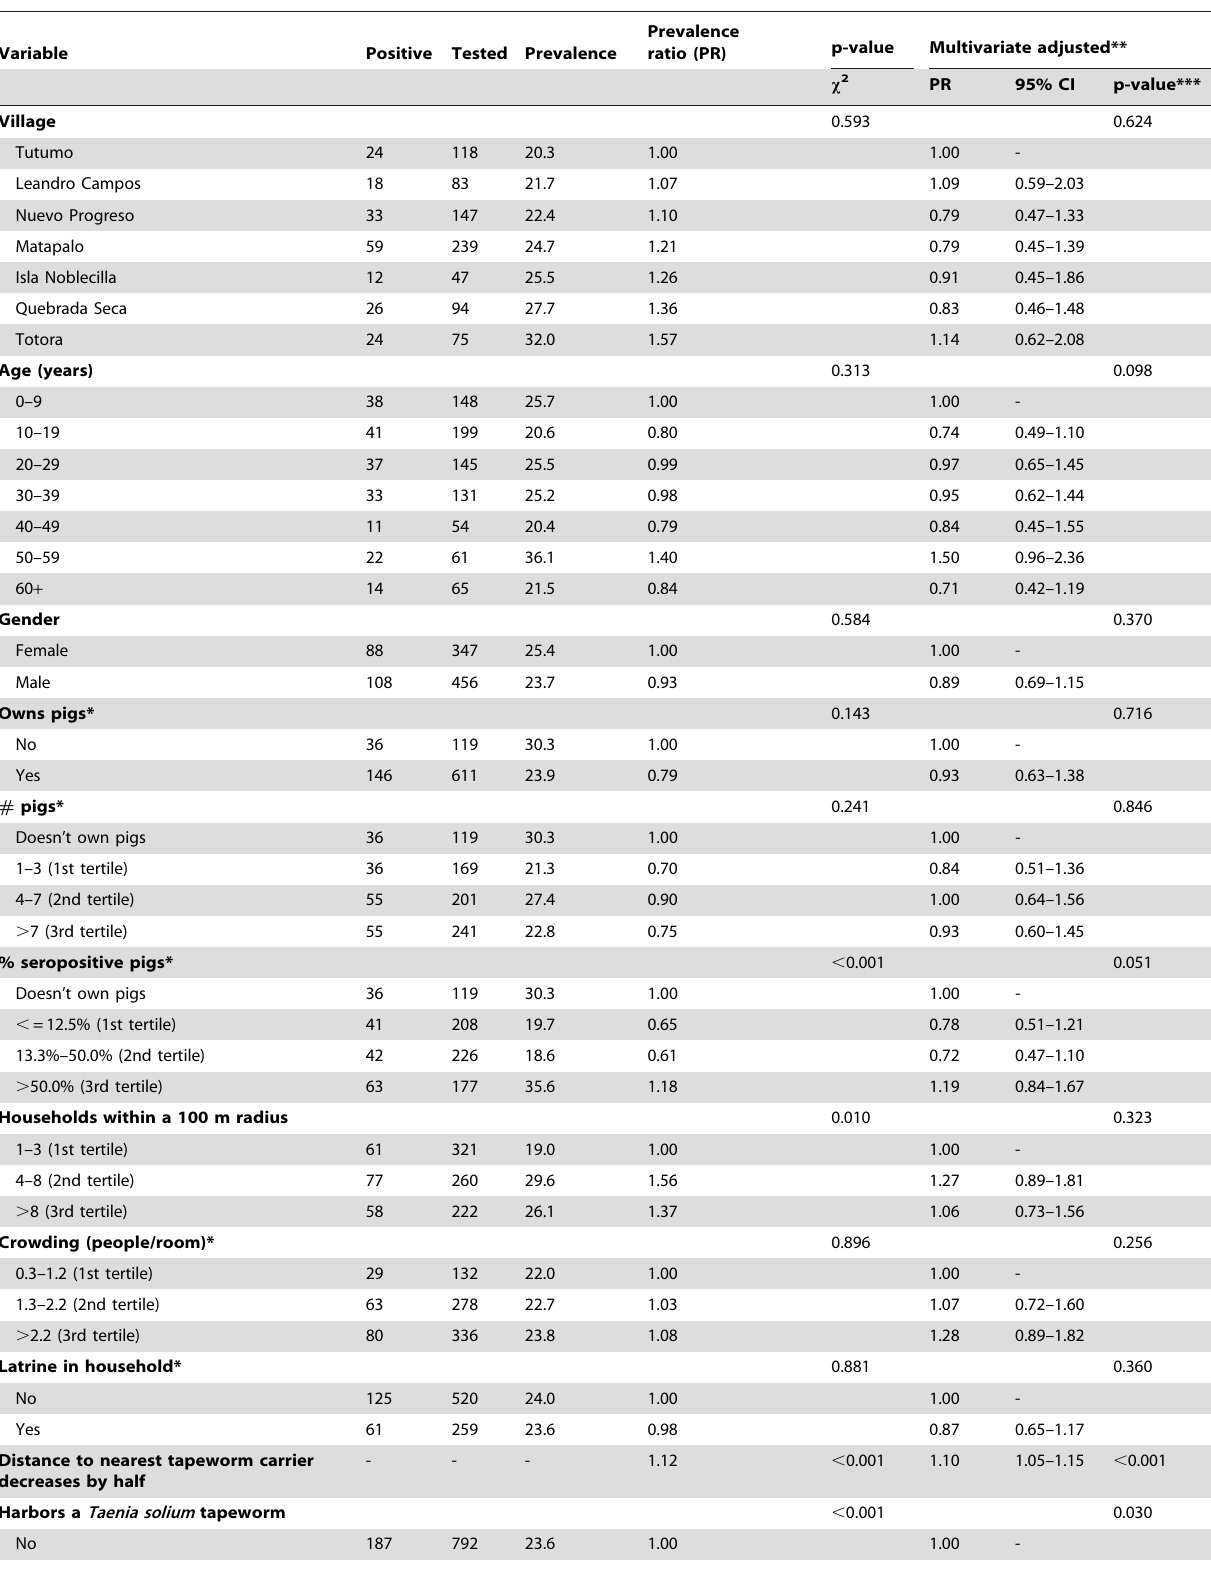
Table 1. Covariate associations with the seroprevalence of human cysticercosis, Tumbes - Peru, 1999.